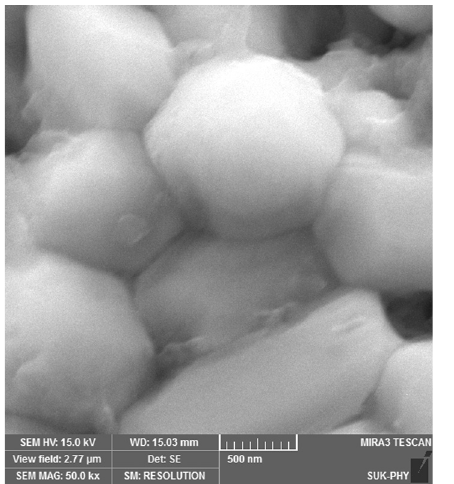
Table 1: Experimental results with carbon - coated micro - tool